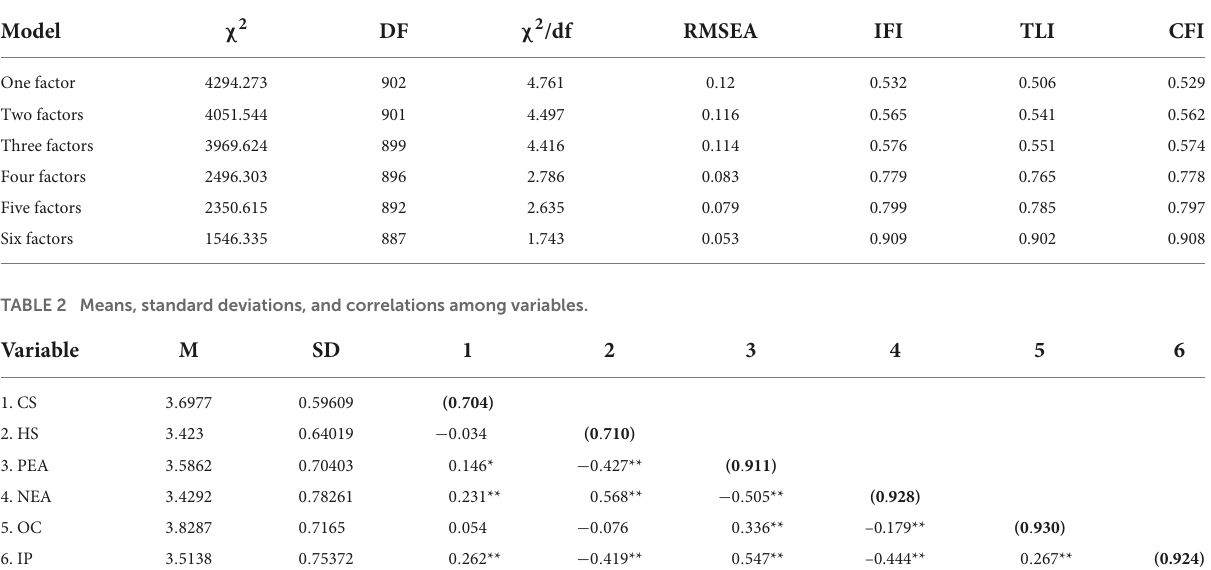
TABLE 1 Confirmatory factor analysis results.